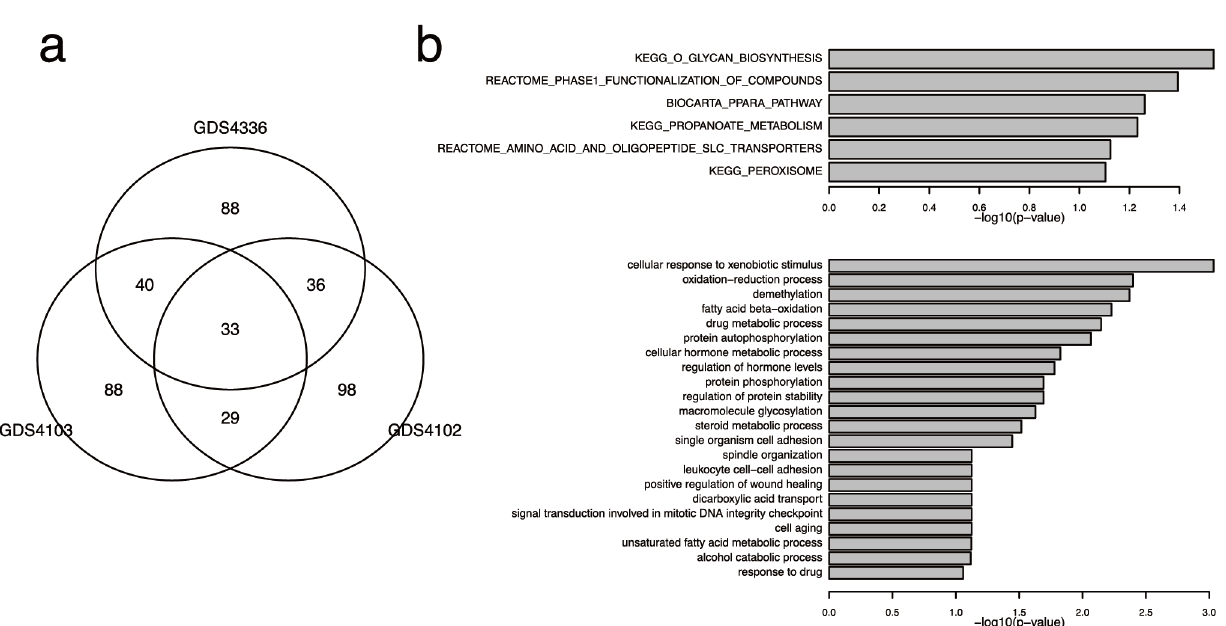
PLOS ONE | DOI:10.1371/journal.pone.0149896 February 24,